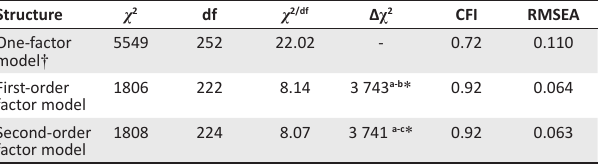
TABLE 12: Comparison of a priori Psychological Capital Questionnaire four-factor structure (adapted factor structure). Structure